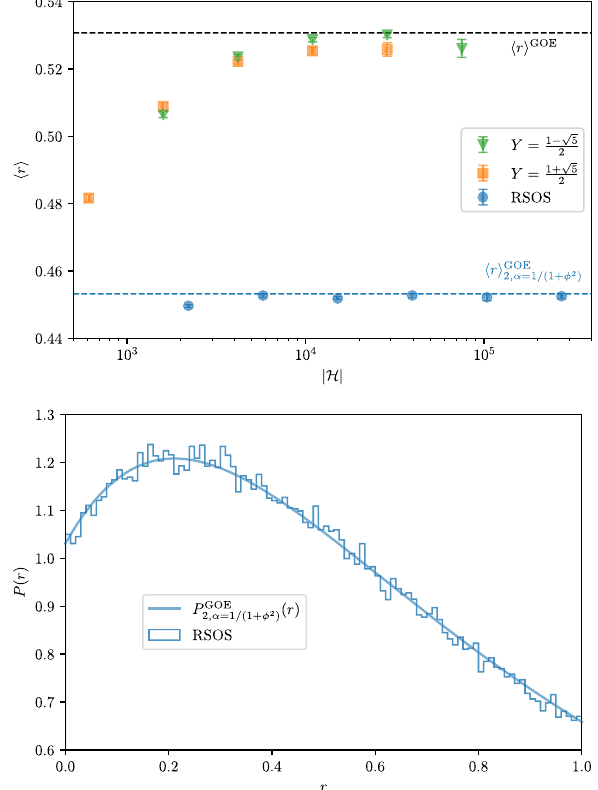
FIG. 8. RSOS model. Top panel: average gap ratio h r i for the RSOS model in Eq. (71), as a function of Hilbert space size. Blue circles are the results for the full spectrum of the Hamiltonian (69); ffiffiffi p 5 = 2 Þ sectors. squares and triangles are those in the Y ¼ ð 1 (cid:5) The dashed lines represent the results for the (single-block) GOE distribution of Ref. [18] and from the surmise computations in Sec. III for m ¼ 2 GOE blocks with size ratio ϕ − 2 . Data in the ffiffiffi p 5 Y ¼ ð 1 þ Þ = 2 sector were obtained by comparing the energy spectrum in the loop representation with noncontractible loop weight 2 cos ð π = 5 Þ and the RSOS representation. Data in the Y ¼ ffiffiffi p 5 ð 1 − Þ = 2 were obtained by considering the rest of the states in the RSOS representation. We focus on mid-spectrum eigenstates of the RSOS spectrum, obtaining about 300 eigenstates for every disorder realization. Results are averaged over between 300 and 1000 realizations of disorder of strength ϵ ¼ 0 . 2 . Bottom panel: probability distribution of the gap ratio P ð r Þ , as obtained from simulations of a RSOS chain of size L ¼ 22 . The solid line is the surmise P GOE ð r Þ obtained from the analytical compu- m ¼ 2 ; α ¼ 1 = ð 1 þ ϕ 2 Þ tations in Sec.